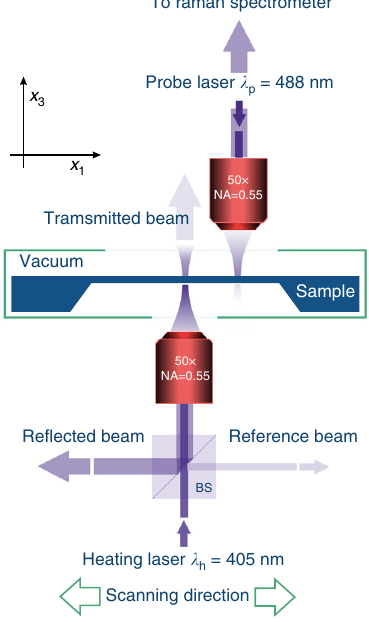
Fig. 6 Schematics of the two-laser Raman thermometry experiment. The setup is based on the triple-grating Raman spectrometer (T64000, Horiba) and the vacuum temperature controlled microscope stage (THMS350V, Linkam). The non-polarising cube BS and three powermeters are used to determine the absorbed power P 0 from intensities of the incident, transmitted and re fl ected laser